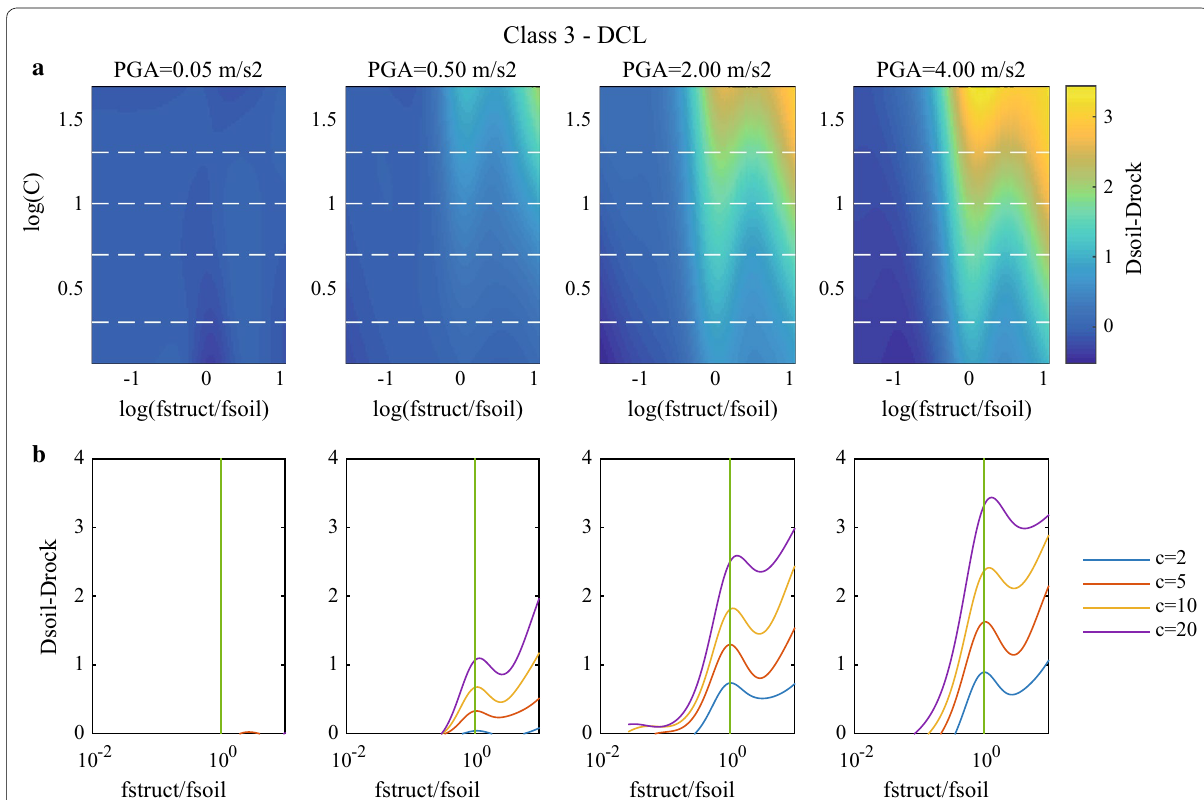
Fig. 5 Variation of the class 3 (RC, low ductility) rock‑to‑soil damage increment as a function of the structure and soil frequency ratio f struct / f soil , and the velocity contrast C , for four different values of PGA (from weak on the left to strong on the right ). The color code on the top frames corresponds to the Δ(DI), while the bottom curves correspond to Δ(DI) as a function of f struct / f soil for four values of c indicated by horizontal dashed white lines in top